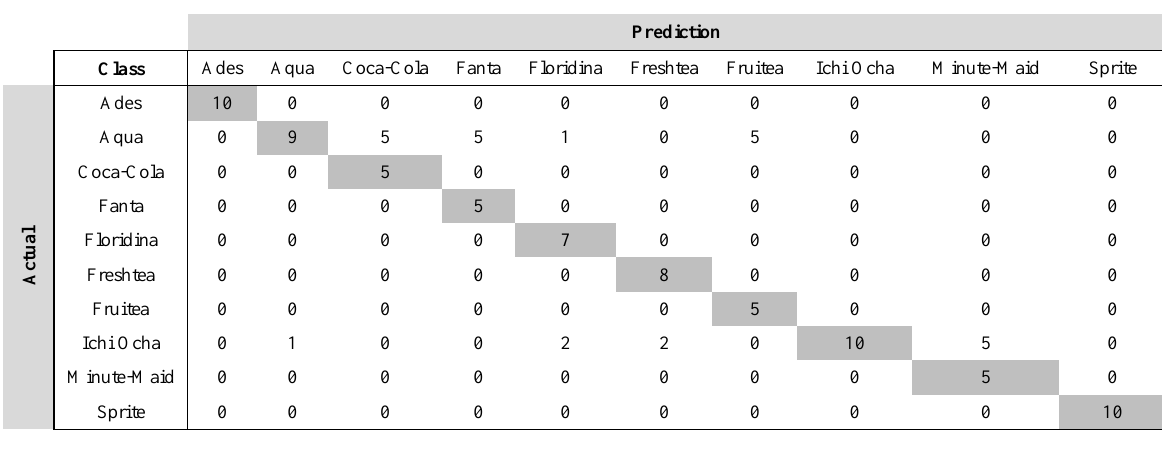
Table 4. Result Confusion Matrix